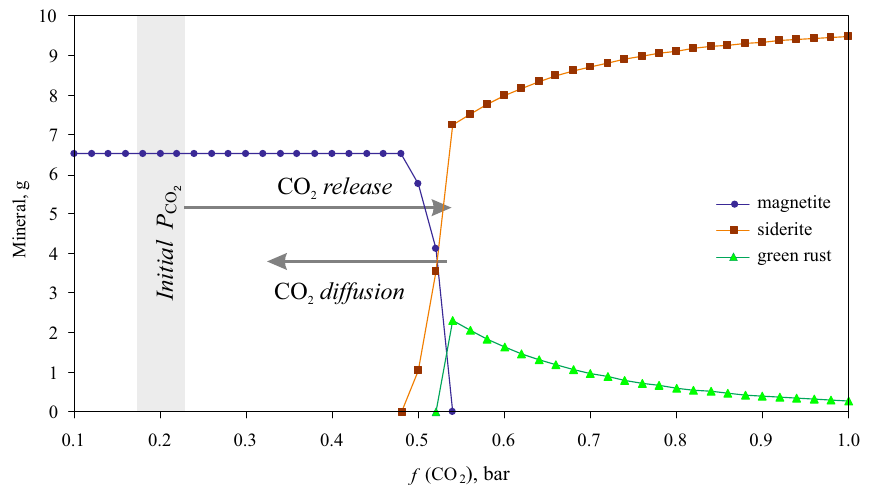
Figure 4. Thermodynamic calculations of equilibrium mineral associations at f (CO 2 ) from 0.1 to 1.0 bar made for experimental conditions. Initial CO 2 fugacity (0.2 bar) changes in the layer of siderite which is not stable. Carbon dioxide released by reaction (1) can induce a local increase of CO 2 . At a carbon dioxide fugacity more than 0.52 bar siderite becomes stable